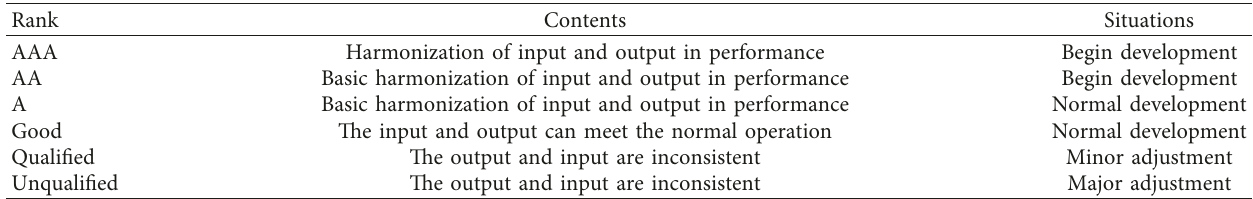
Table 7: Result evaluation rank interpretation of enterprise informatization performance.